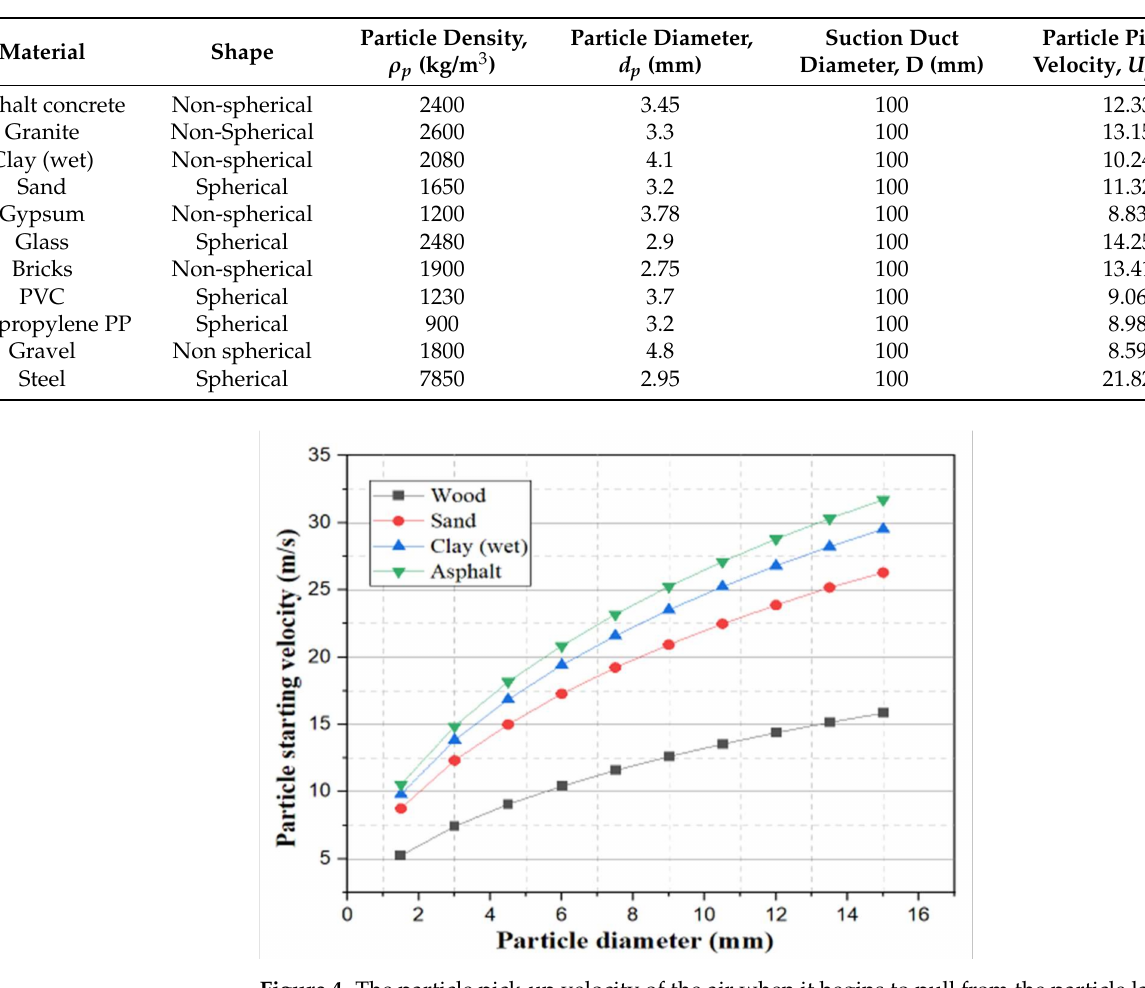
Table 4. Particle pick-up velocity (air velocity at the beginning of the pick-up from the particle layer) (m/s).